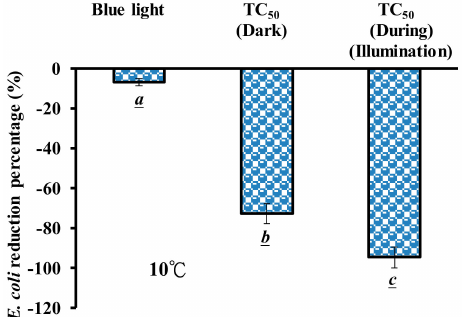
Figure 6. Effects of TC treated with blue light illumination on the viability of E. coli at 10 ± 1 ◦ C. As a control, 50 mg/L TC in the dark was used. The reduction of E. coli during the photochemical reaction process was treated with 50 mg/L TC under blue light illumination at 2.0 mW/cm 2 for 120 min (during illumination treatment). Data are represented by mean ± SD, where n = 3. Statistical differences ( p < 0.05) between groups are indicated by the different letters below each bar.